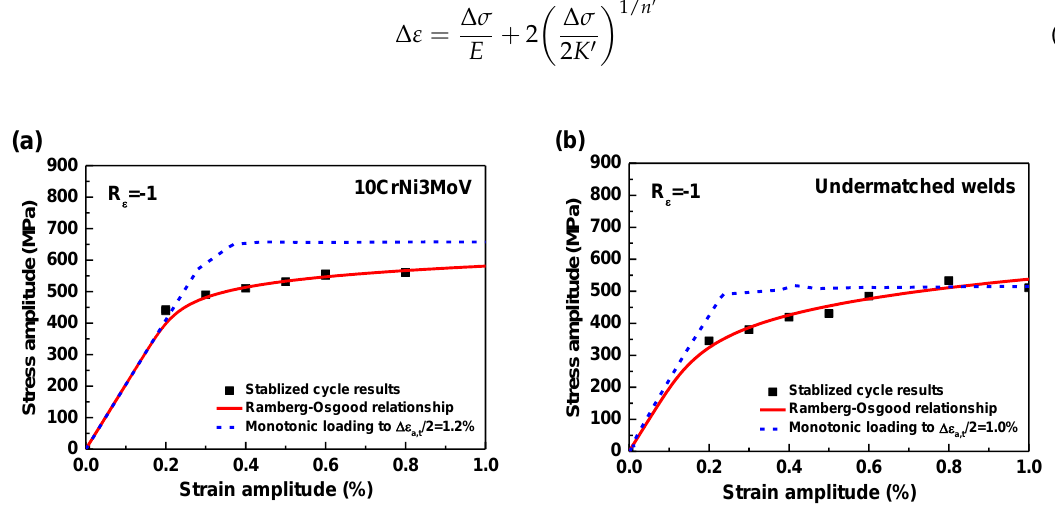
Figure 6. Stabilized stress-strain hysteresis loops and cycle Ramberg-Osgood relationships under different amplitudes: ( a ) 10CrNi3MoV steel; ( b ) Undermatched welds.